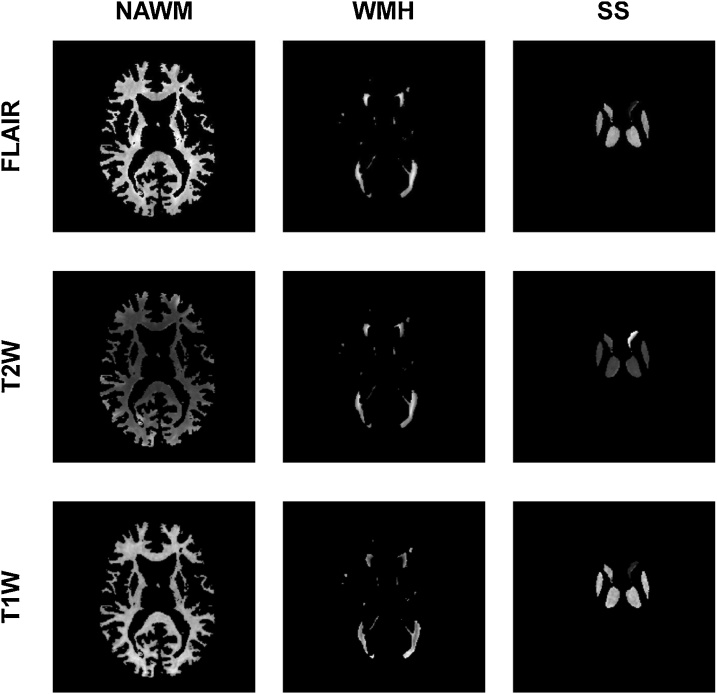
Set of images obtained in each patient. In this representative case, T1-weighted (T1W), T2-weighted (T2W) and fluid-attenuated inversion recovery (FLAIR) brain images of normal appearing white matter (NAWM), white matter hyperintensities (WMH) and subcortical structures (SS) of a lacunar stroke patient are presented.